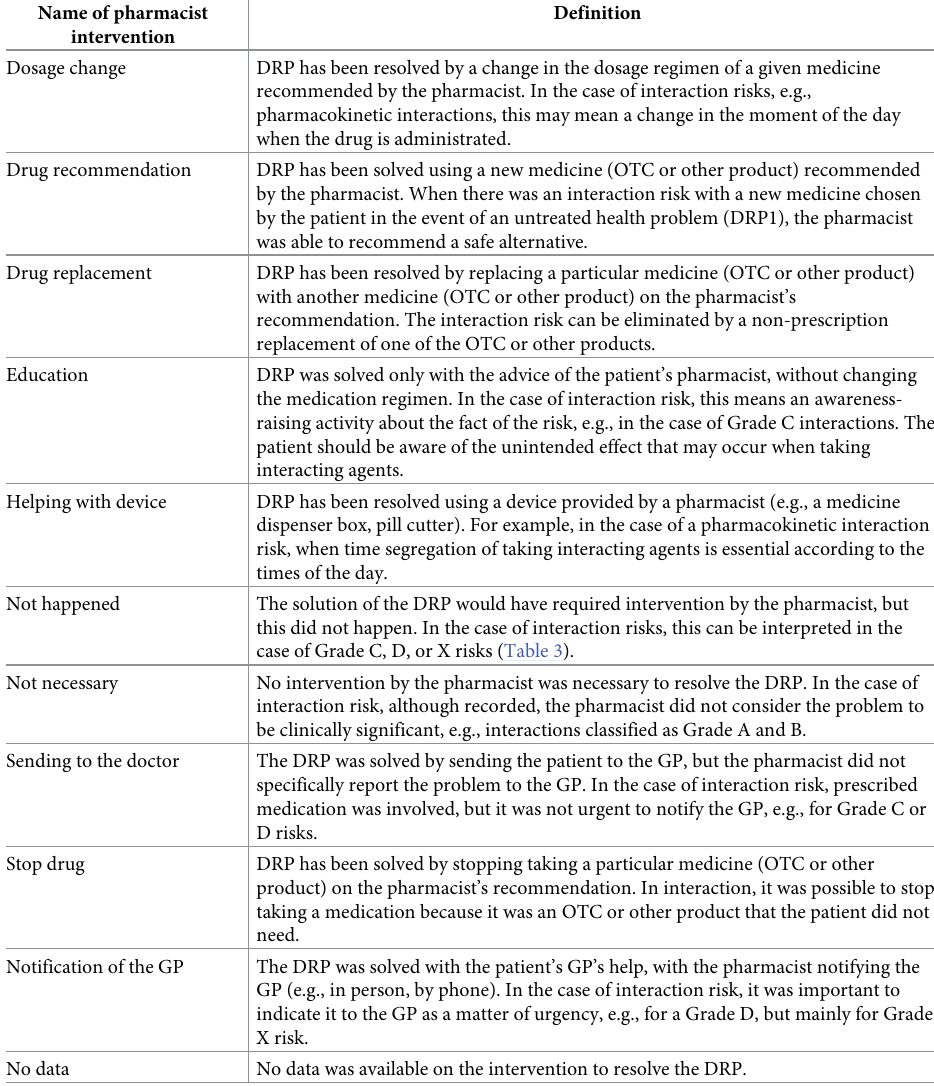
Table 4. Definitions of pharmacist interventions to solve drug-related